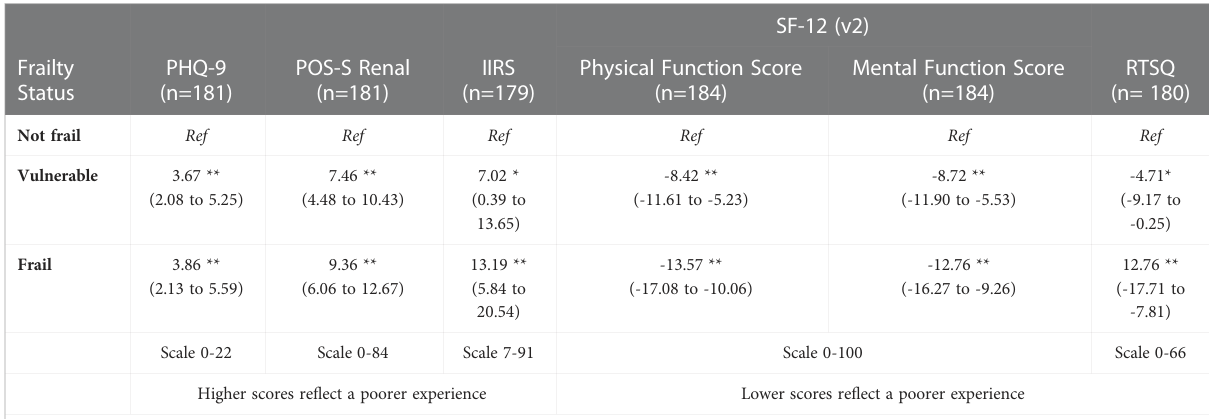
TABLE 3 Patient experience scores and their variation by identi fi ed frailty status.